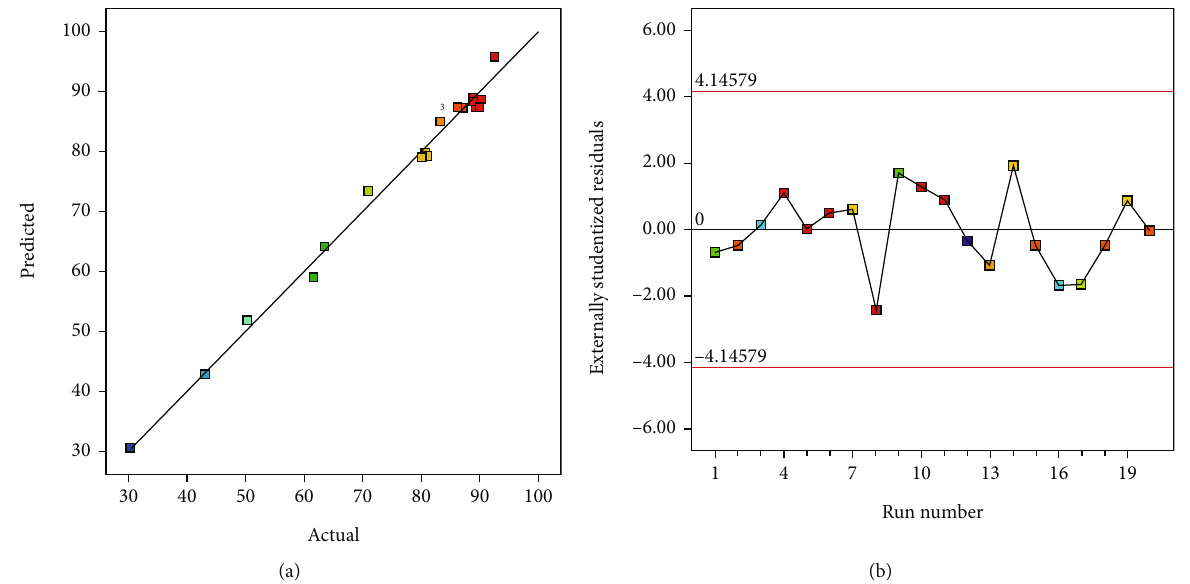
Figure 1: (a) The model predicted vs. the actual Pb 2+ ion removal (%) and (b) externally studentized residual vs. run number.